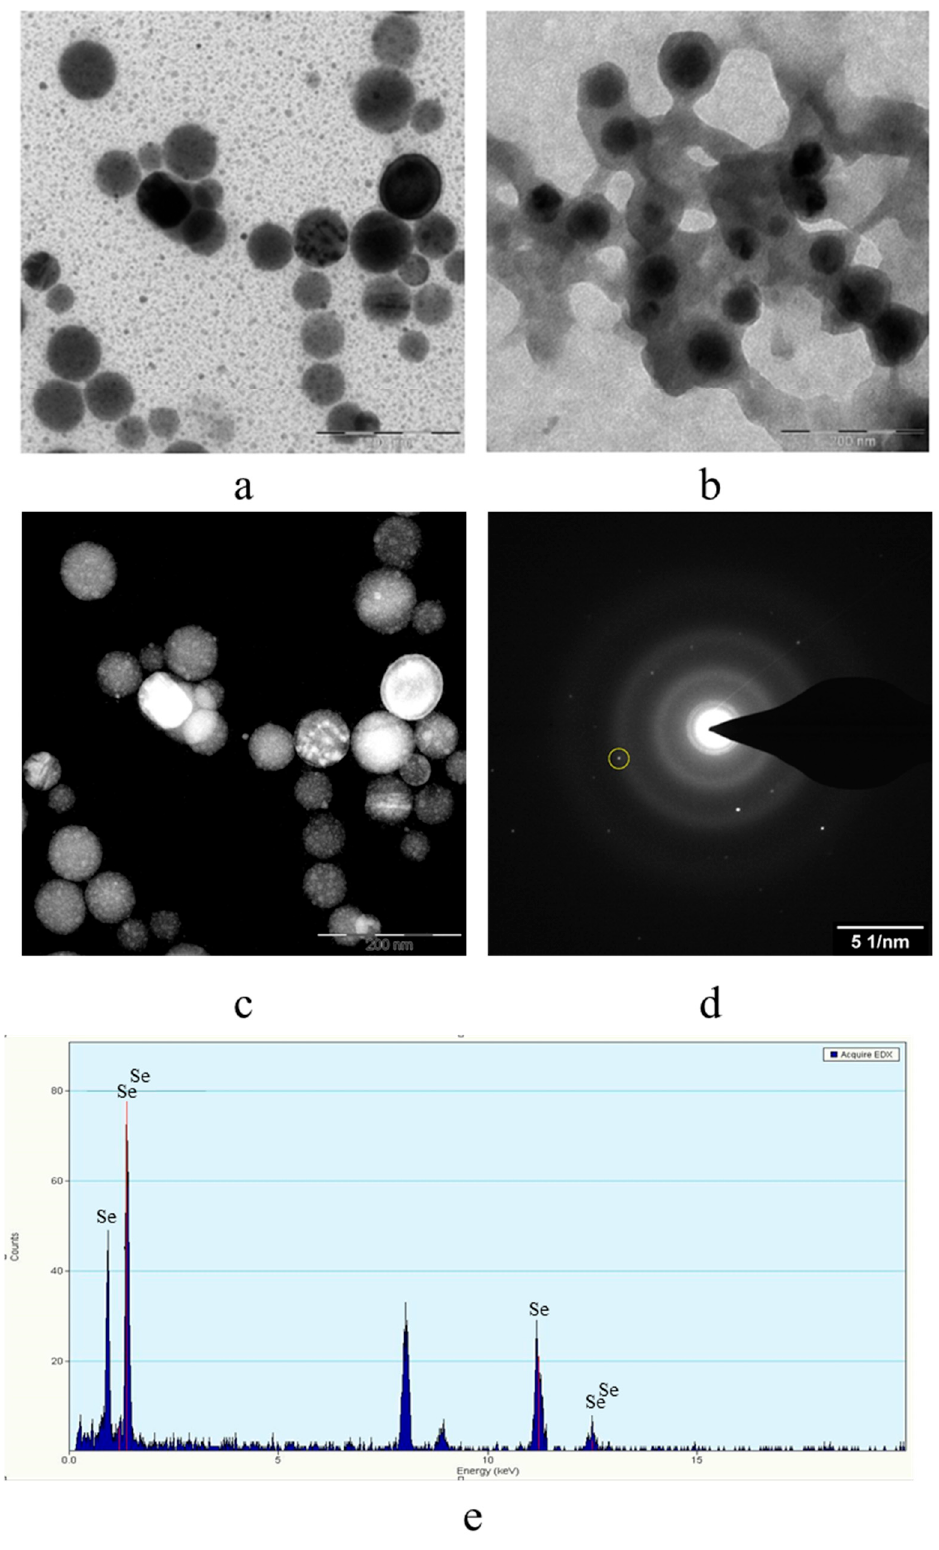
Figure 6. TEM image of samples of Se NPs stabilized with catamine AB: negatively charged sample ( a ), positively charged sample ( b ), dark-field image of one of the particles at higher magnification ( c ); electron diffraction pattern from the selected area ( d ), and spectrum by elements from the selected particle ( e ).